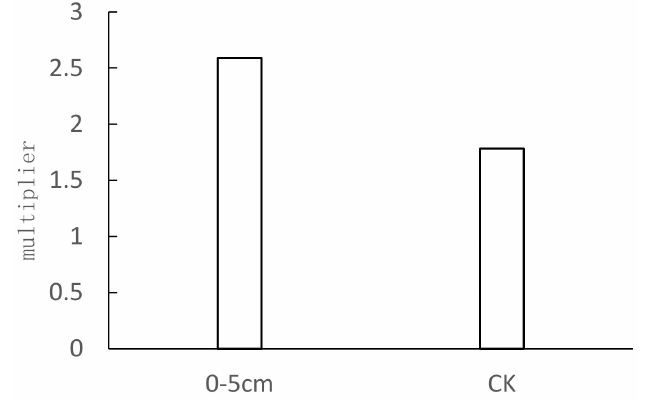
Figure 2. Comparison graph of condensate generation